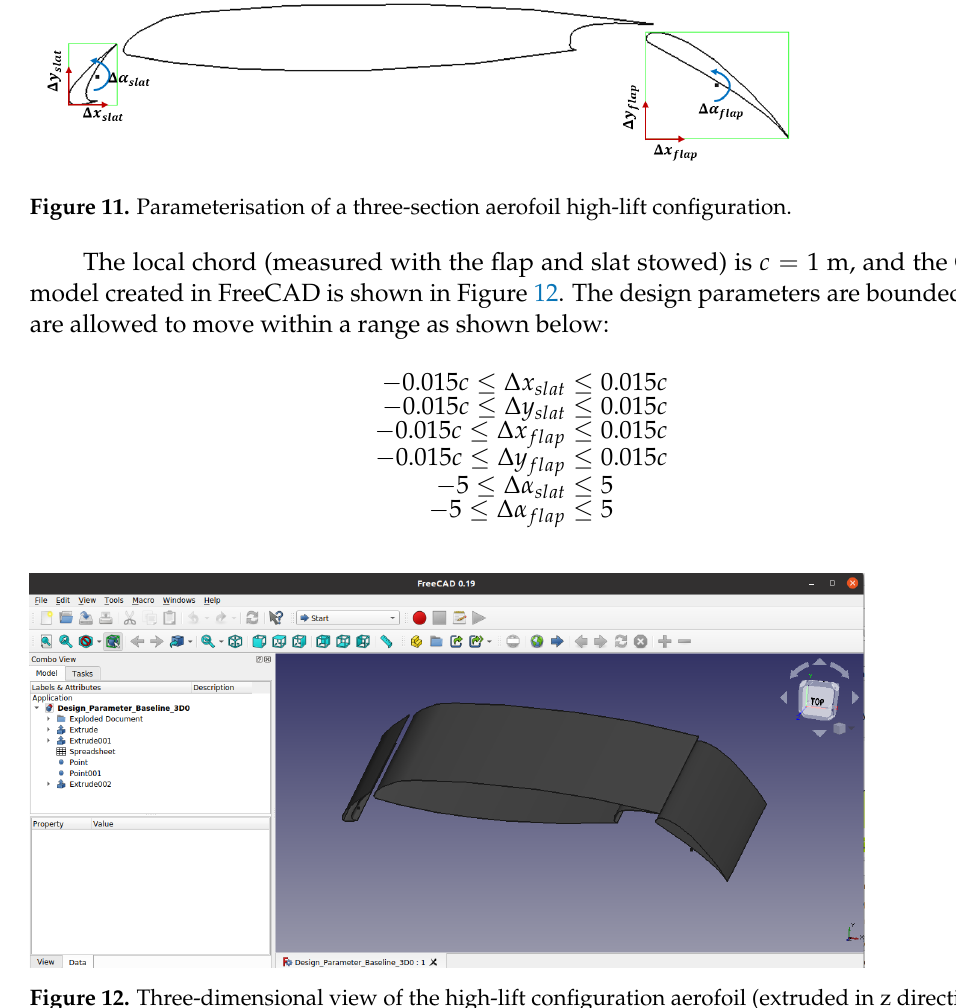
Figure 12. Three-dimensional view of the high-lift configuration aerofoil (extruded in z